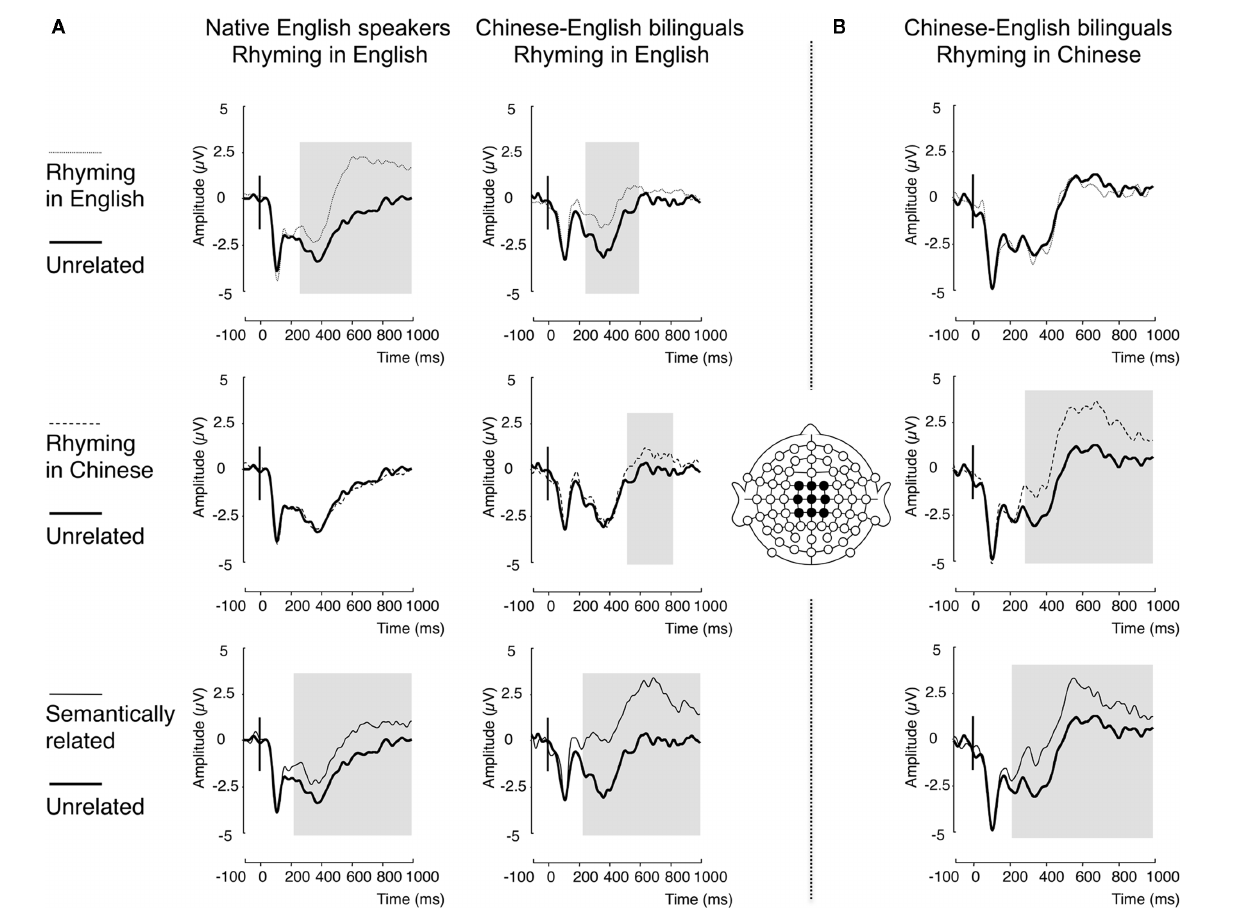
FiguRE 3 | Event-related potential results of all groups in the rhyming judgment tasks. ERP results for the native English speakers and the Chinese–English bilingual speakers in the English rhyming judgment task are presented to the left of the vertical line (A) . ERP results for the Chinese– English bilingual speakers in Chinese rhyming judgment task are presented to